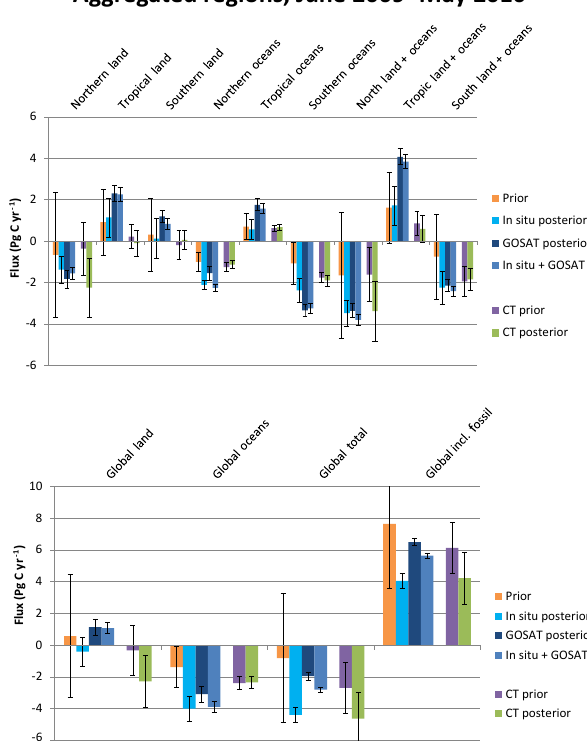
Figure 8. Twelve-month mean NEP ( ×− 1), fire, and ocean fluxes aggregated over large regions. Included are results for the in situ only, GOSAT only, and in situ + GOSAT inversions as well as pri- ors. Shown for comparison are priors and posteriors from CT2013B. Error bars represent 1 σ uncertainties; for CT2013B, “external” (across a set of priors) as well as “internal” (within a particular in- version) uncertainties are included. In summing monthly CT2013B fluxes over the 12 months, we assumed zero error correlation be- tween months.